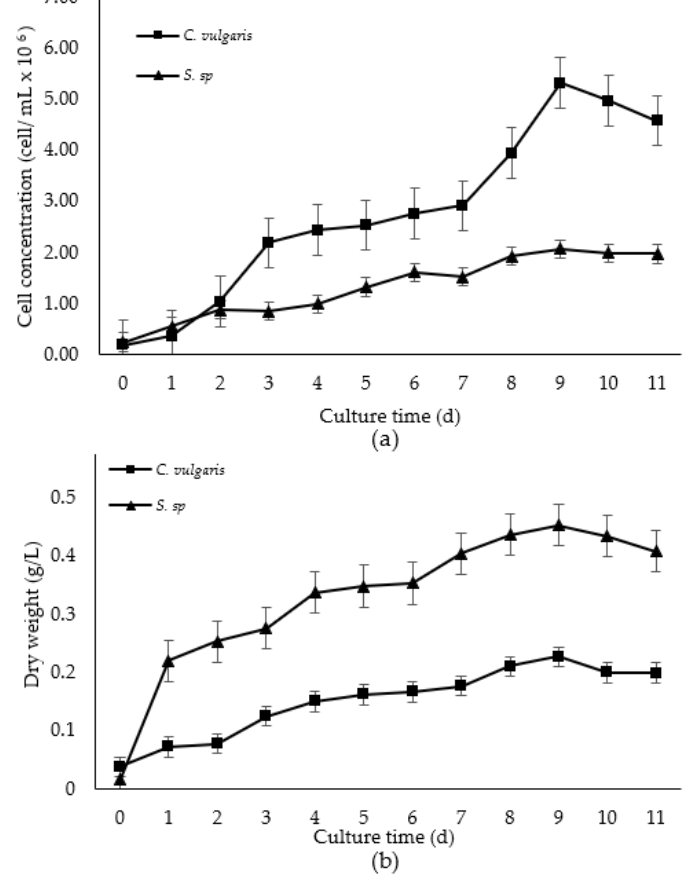
Figure 1. Cell growth of Scenedesmus sp. and Chlorella vulgaris in pig slaughterhouse wastewater for 11 days: ( a ) Cell concentration (cells/mL) vs. Time and ( b ) Dry weight (g/L) vs. Time. The values are presented as means of triplicate measures with their corresponding standard deviation (±SD).